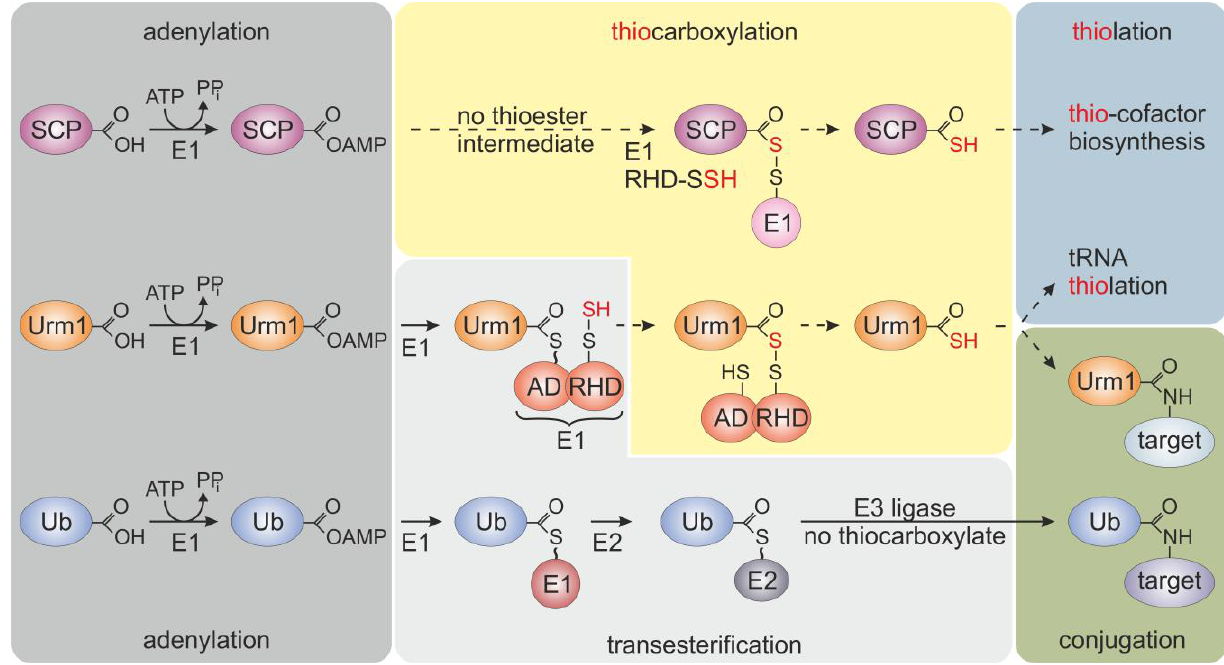
FIGURE 1: Selected members of the ubiquitin-fold protein family. Prokaryotic sulfur carrier proteins (SCP) as well as eukaryotic Urm1 and ubiquitin (Ub) all require activating adenylation by E1-type enzymes. For the Ub pathway, E1 activation results in an E1~Ub thioester that is passed onto E2/E3 enzymes via transesterifications and eventually conjugated to lysine residues in target proteins. By contrast, E1-type adenylation of SCP does not follow a thioester intermediate; rather a dedicated desulfurase and rhodanese domain (RHD) protein (i.e., IscS, not shown) engages in sulfur transfer, persulfidation (-SSH) and eventually, thiocarboxylation (SCP-COSH) for use of SCP as a sulfur donor in thiolation reactions including thio-cofactor synthesis [4, 21]. As for Urm1, following adenylation a thioester is formed to the adenylation domain (AD) of Uba4, the E1-type enzyme for Urm1, and passed over to a persulfide (-SSH) on the RHD of the same enzyme.